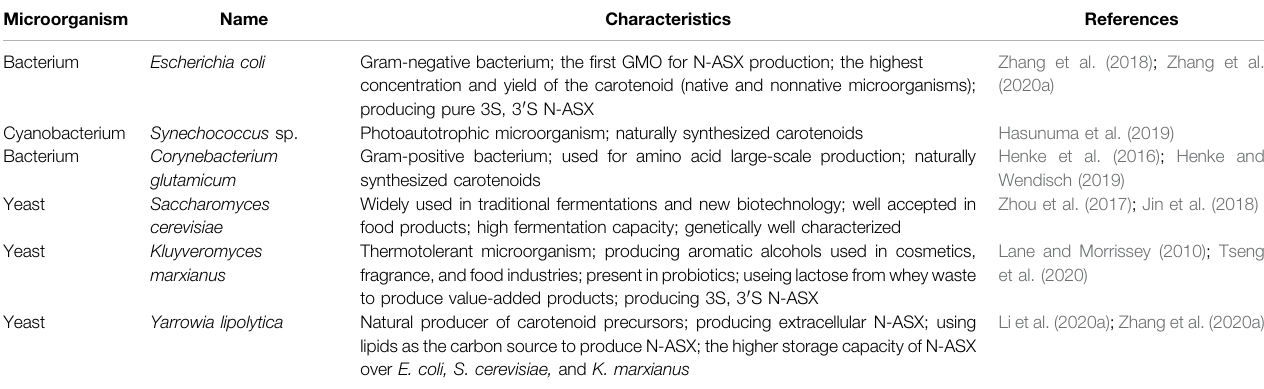
TABLE 3 | Main genetically modi fi ed microorganisms (GMO) for N-ASX production.